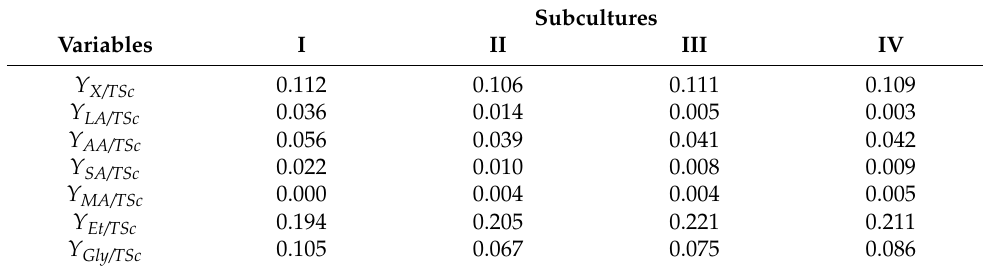
Table 4. Fermentation Yields Calculated at the End of Every Subculture in Fed-Batch Fermentation B. Y X/TSc , Y LA/TSc , Y AA/TSc , Y SA/TSc , Y MA/TSc , Y Et/TSc , and Y Gly/TSc are respectively, the Mean Yields (g/g) of Free Biomass (X), Lactic Acid (LA), Acetic Acid (AA), Succinic Acid (SA), Malic Acid (MA), Ethanol (Et) and Glycerol (Gly) on Total Sugars Consumed (TSc).